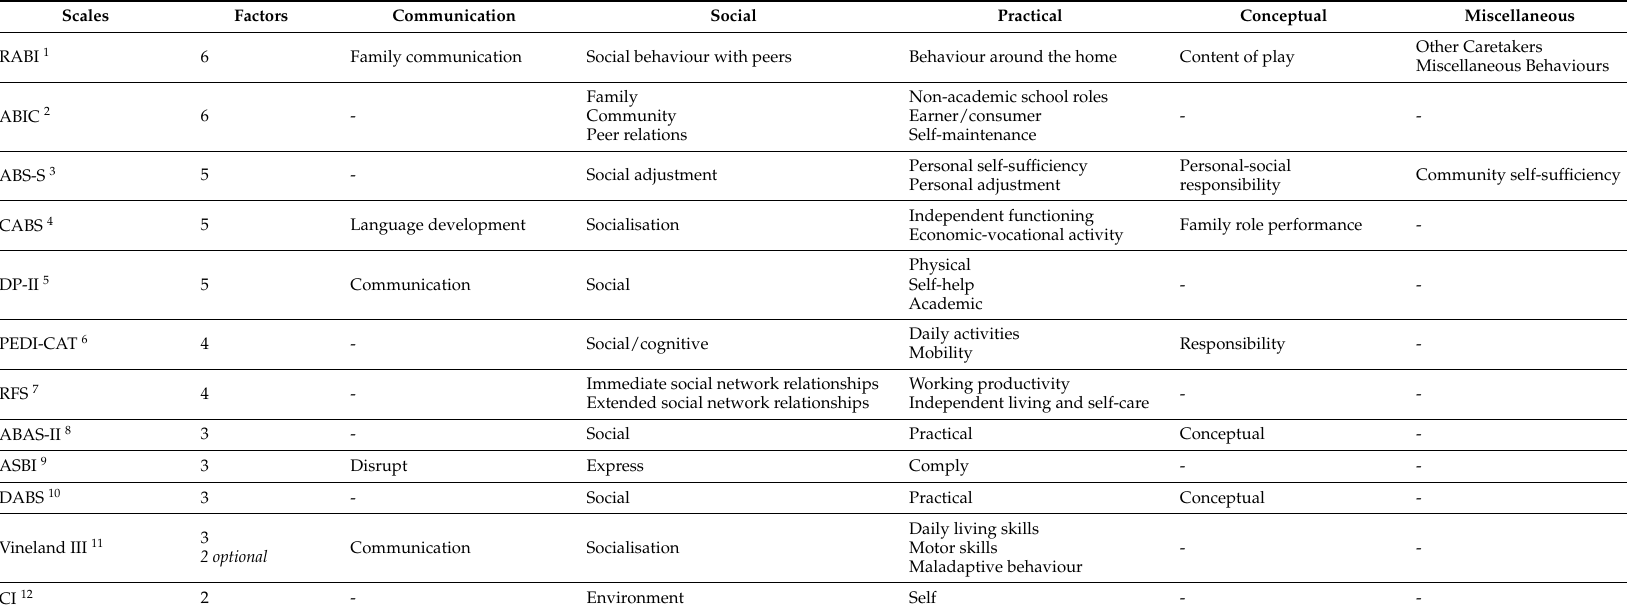
Table 4. Factors from adaptive behaviour assessment scales mapped across